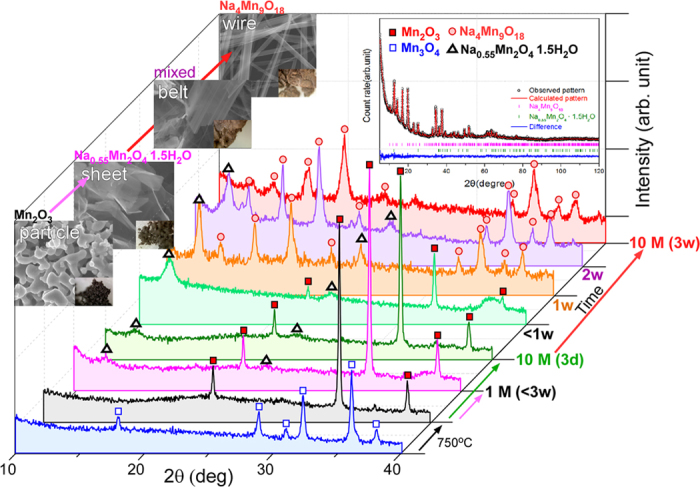
XRD patterns of the starting materials (Mn3O4 and Mn2O3) and the synthesized materials according to the reaction time in the 1.0 and 10 M NaOH solution.The insets show the corresponding SEM images (left) and Rietveld refinement powder XRD patterns of a mixed phase sample (top right). The additional Figures are provided in the Supporting Information (Figs S1, S2, and S3a, S3b) to understand the change in the crystal phase with varying reaction conditions. The reaction time was written on the right of the corresponding XRD.